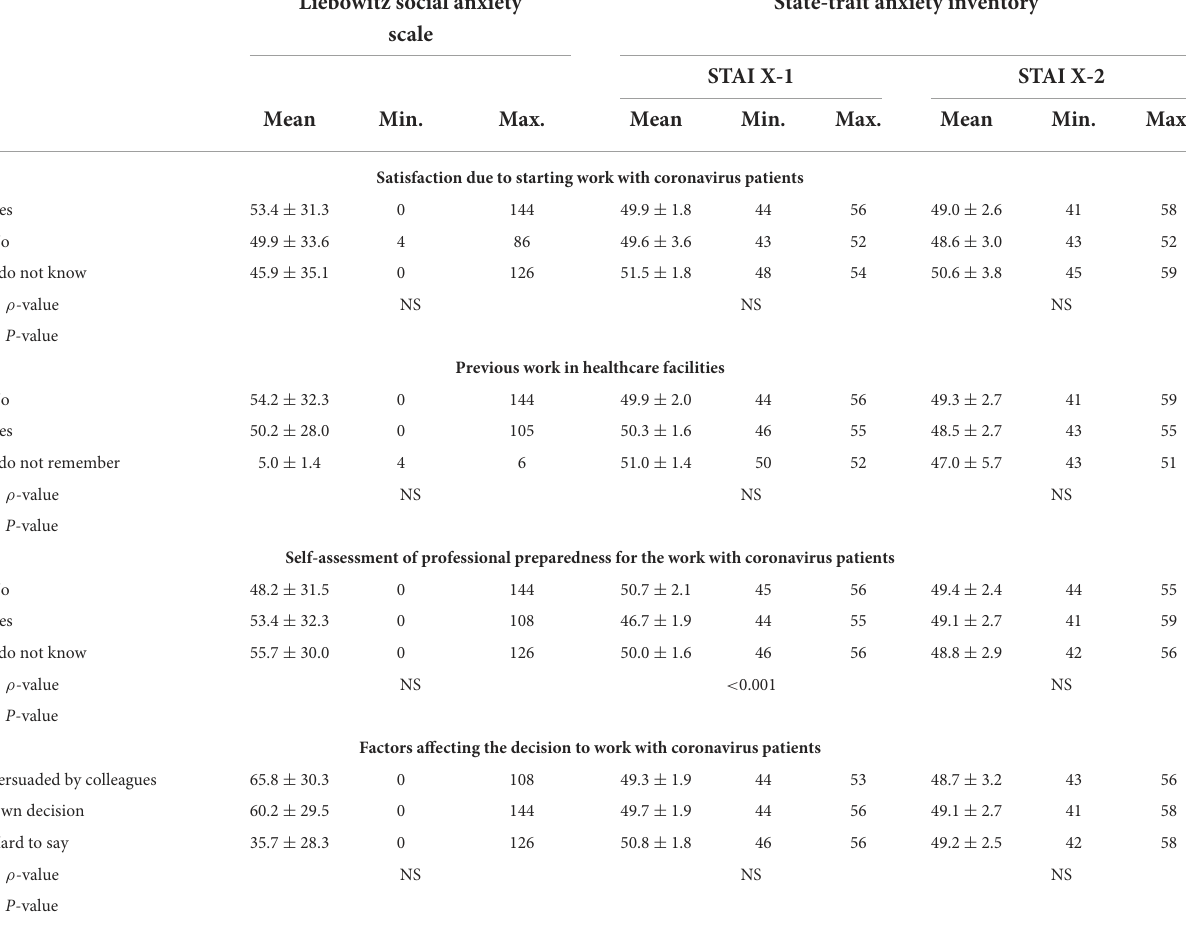
TABLE 4 Level of social anxiety, state anxiety (X-1) or trait anxiety (X-2) and satisfaction with starting work with coronavirus patients, previous work experience in healthcare facilities, self-perceived professional preparedness for work with coronavirus patients and motivation for starting such work.